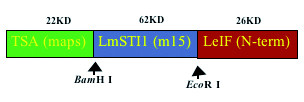
Schematic representation of Leish-111f construct containing tandemly linked genes of TSA, LmSTI1 and LeIF.